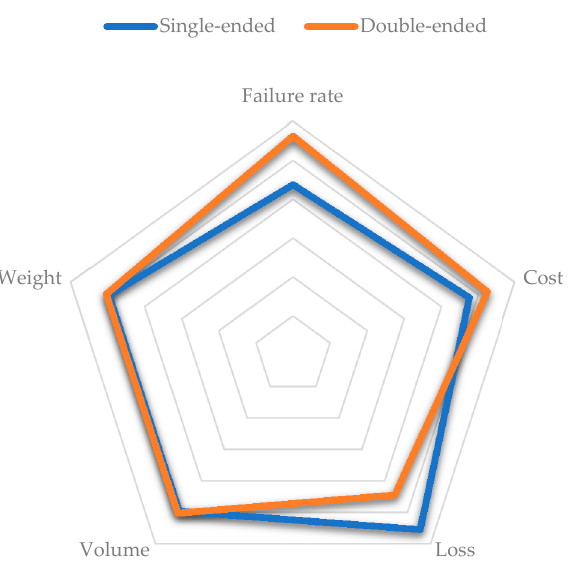
Figure 17. Comparison of volume, weight, power loss, cost, and failure